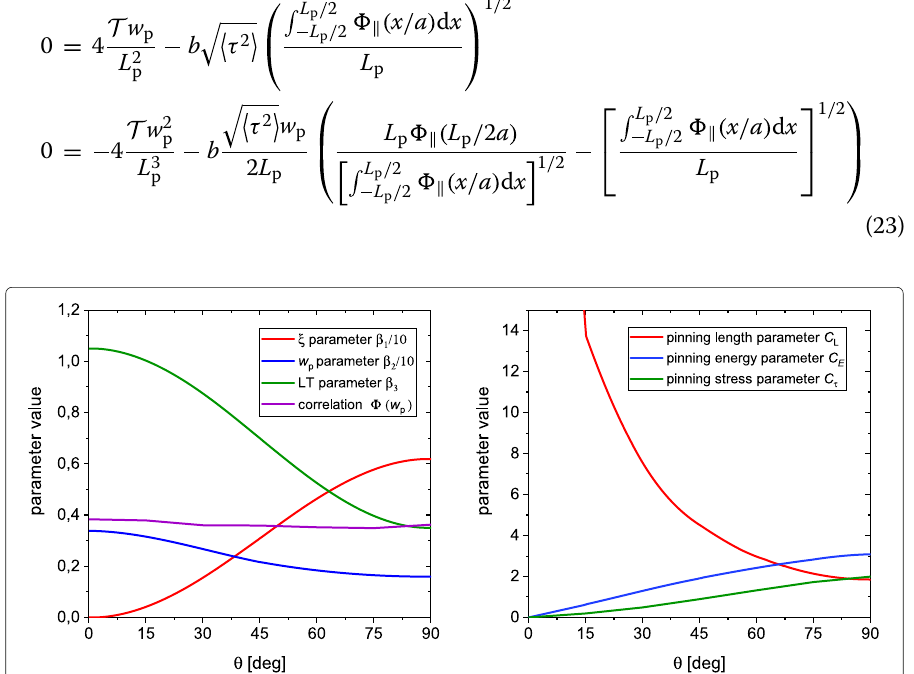
Fig. 3 Left: Dependence of scaling parameters on dislocation orientation angle ; right: Corresponding parameters C L , C E and C which govern the angle dependence of the pinning length, pinning energy and pinning stress,